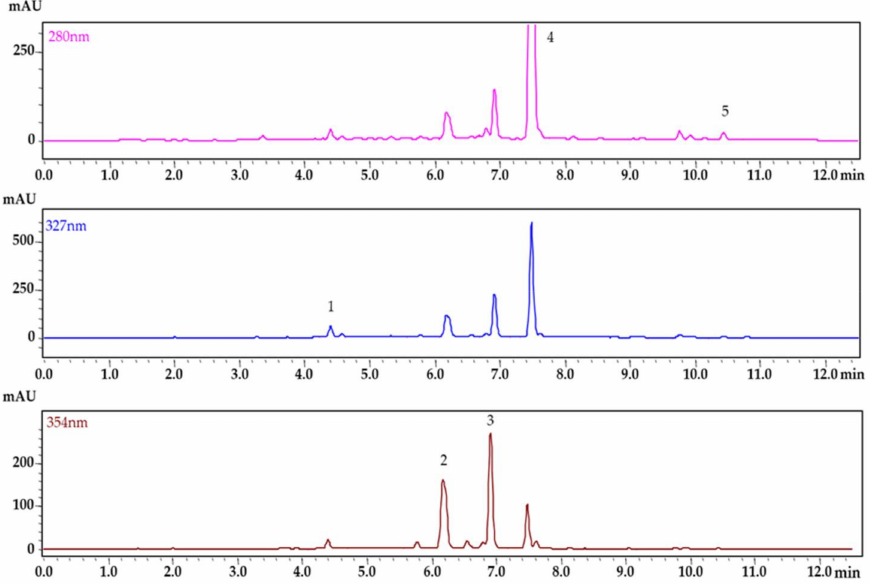
Figure 3. Chromatogram of phenolic compounds from apple bark extract. (1) chlorogenic acid, (2) rutin, (3) quercitrin, (4) phloridzin, (5)